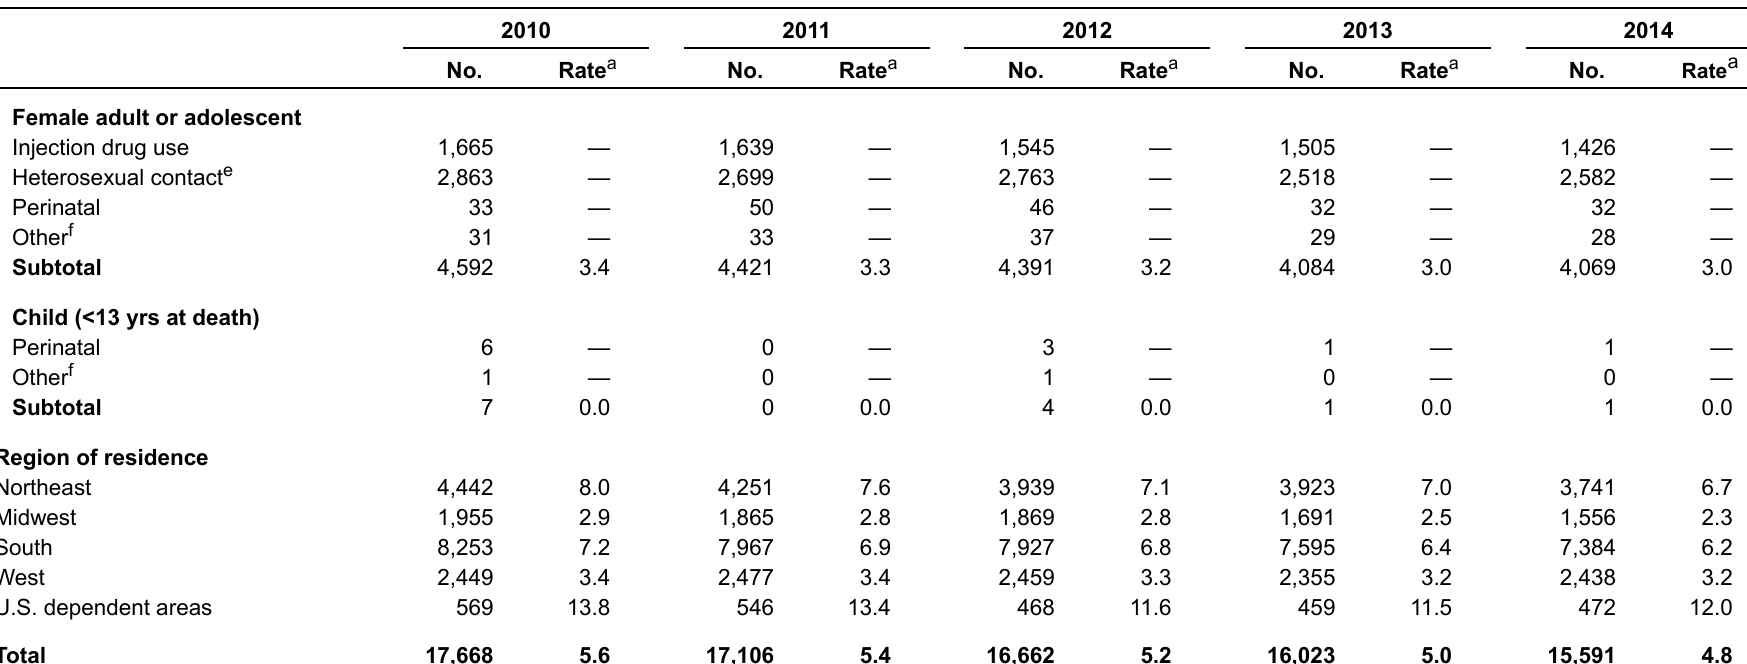
Table 12b. Deaths of persons with diagnosed HIV infection, by year of death and selected characteristics, 2010–2014—United States